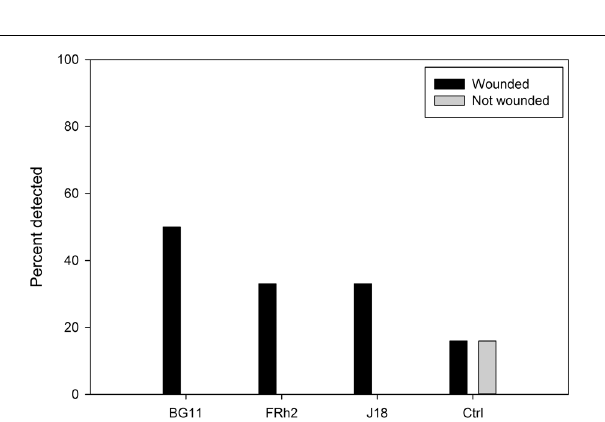
FIGURE 5 | Percentage of ef1 α Beauveria bassiana detected by PCR in samples from the rhizosphere of Zea mays (maize) ( Y axis) at 30 days after inoculation (DAI), for different isolate treatments versus a no-inoculum control ( X axis). Compared are the percentage of B. bassiana present in soils from plants that were wounded versus those not-wounded